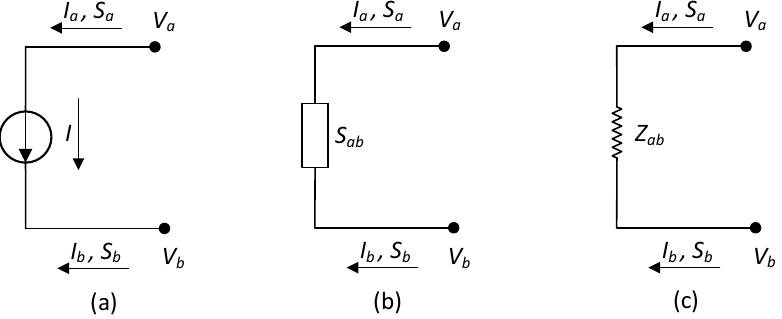
Figure 1. Interphase power flow model of a single-phase load connected across terminal a and b .